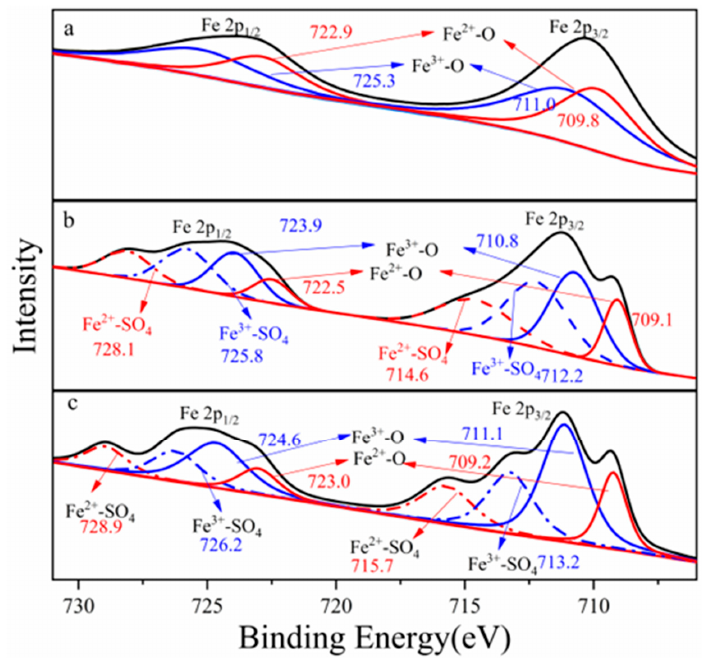
Figure 1. Electron binding energy of Fe 2p, ( a ) ferrocolumbite, ( b ) 8 M H 2 SO 4 acid leaching residue, ( c ) 12 M H 2 SO 4 acid leaching residue.